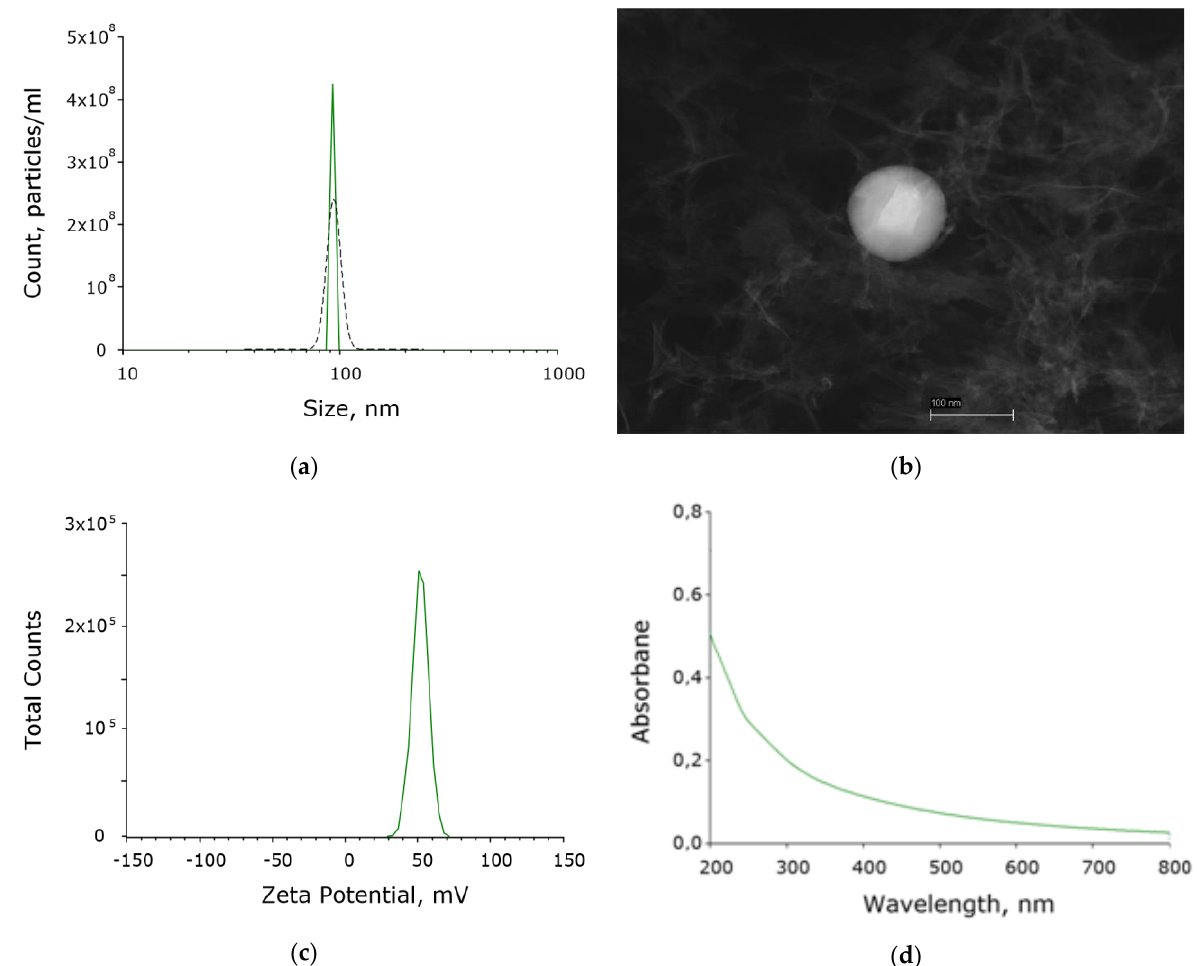
Figure 2. Physicochemical properties of Al 2 O 3 NPs: ( a ) Concentration (DLS, green solid line) and size distribution (differential centrifugal sedimentation, black dashed line) of aluminium oxide NPs; ( b ) TEM image of aluminium oxide NP; ( c ) Zeta potential of aluminium oxide NPs; ( d ) Optical absorption of an aqueous colloidal solution of aluminium oxide NPs.